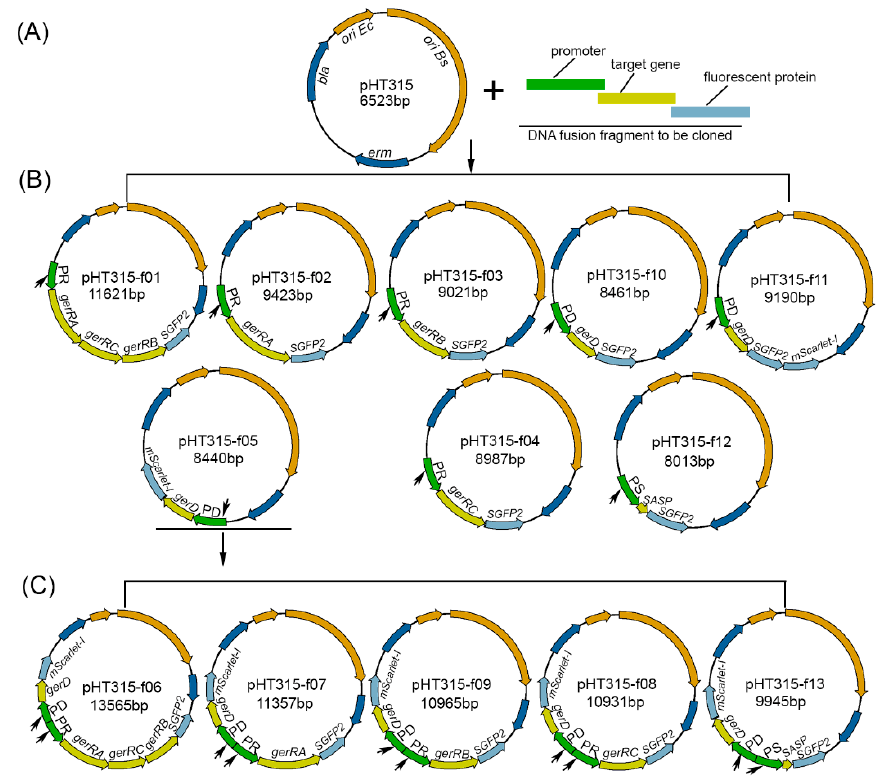
Figure 1. Maps of recombinant plasmids used in this study. The empty vector pHT315 of layer ( A ) was used as the backbone for construction of plasmids in layer ( B ). Plasmid pHT315-f05 of layer B was used as the backbone to construct plasmids in layer ( C ). The black arrows indicate the locations of promoter sequences for fusion genes. The recombinant genes in each of these plasmids are listed in Table 1. Table 1. Strains and plasmids used in this study.